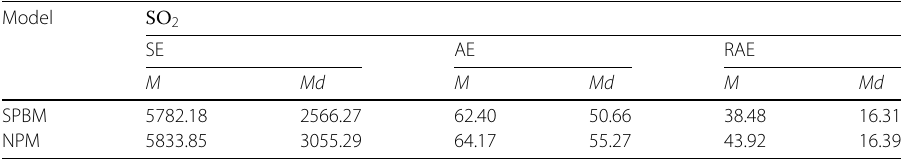
Table 6 SO 2 Forecast